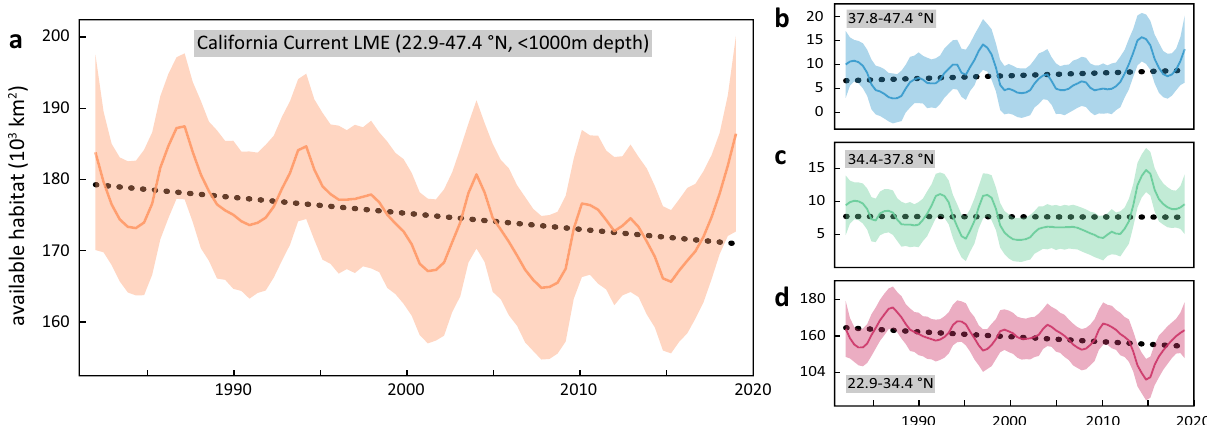
Figure 4. Change in availability of the North Pacific juvenile white shark thermal habitat from 1982–2019. Time series of annal spatial extent of juvenile thermal habitat in a the entire extent of the California Current Large Marine Ecosystem (LME) and separately calculated b–d in three distinct latitude regions, excluding depths > 1000 m. a Across the entire LME the linear change is − 223.2 km 2 year −1 . b In the northern region